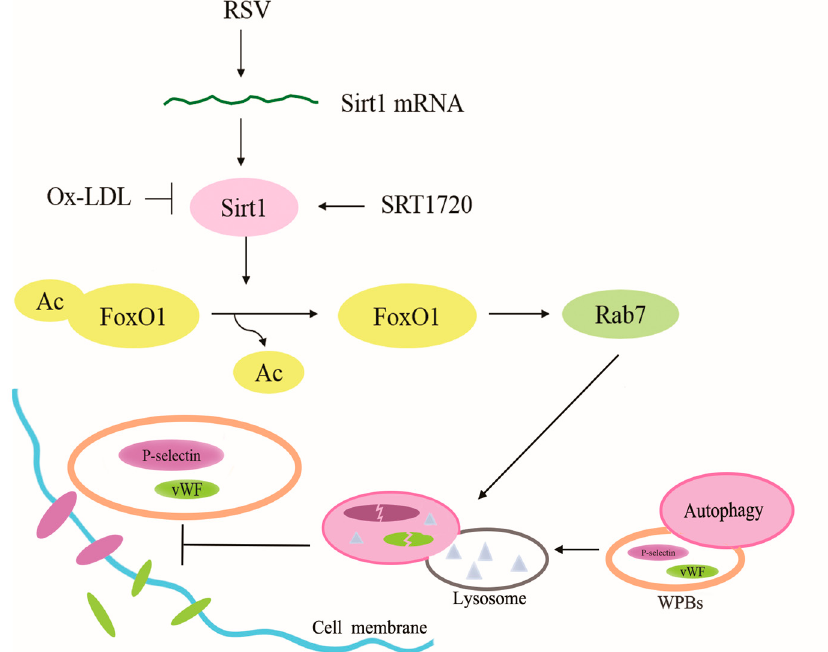
Figure 8. Mechanism of Sirt1/FoxO1 pathway regulating autophagy to modulate the release of vWF and P-selectin (Arrow: activation/increase; T arrow: inhibition).